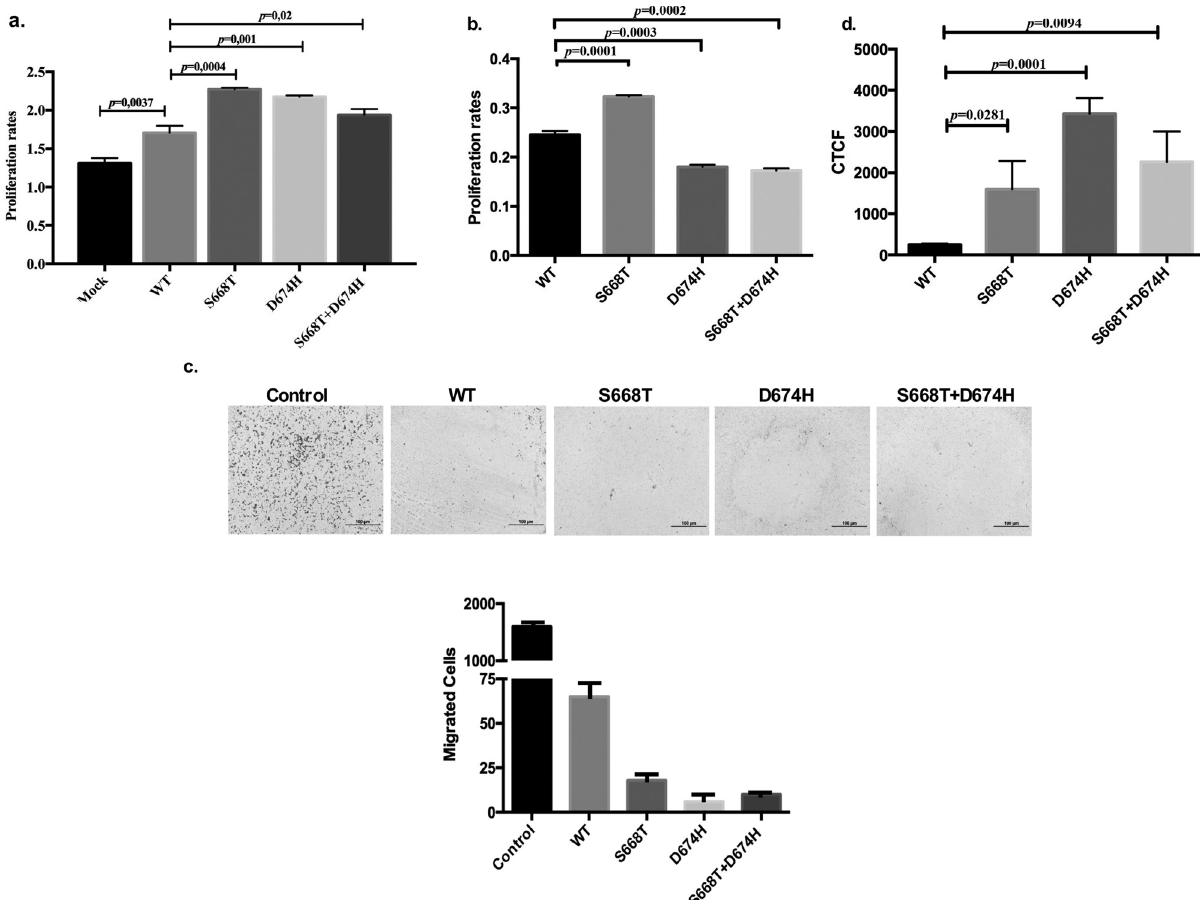
Figure5 -EffectsofIRS1,S668T,D674Handdoublemutants:(a)Onproliferationof293Tcells;293Tcellsweretransientlytransfectedwithexpression vectors for 72 h, and cell viability was measured via MTT assay; (b) on proliferation of A549 cells; A459 cells were transiently transfected with expres- sion vectors for 72 h, and cell viability was measured via MTT assay; (c) on migration of 293T cells; 293T cells were transiently transfected with expres- sion vectors for 24 h, trypsinized, counted and 5000 cells were placed in upper chamber BD Biocoat Insert Systems with 8-micron pore size, se- rum-containing DMEM was added to lower chamber. After overnight incubation, medium in upper chamber was removed, cells were fixed with methanol, and cells in upper chamber were scraped off with cotton swabs. Migrated cells were stained with hematoxylin and eosin. Images of migrated cells were obtained with an Olympus IX51 microscope. (d) Effects of S668T, D674H and double mutants of IRS1 on insulin-induced glucose uptake in A549 cells. A Cayman Glucose Uptake Cell Based Assay Kit was used to determine the level of glucose uptake. (CTCF: Corrected Total Cell Fluores-